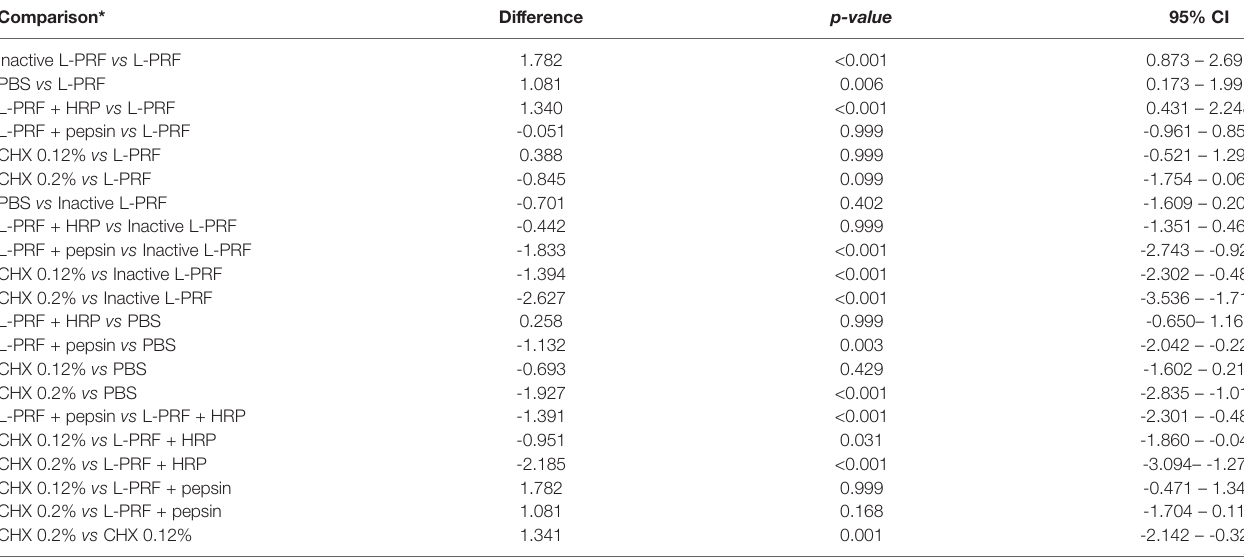
TABLE 4 | Comparisons of the effects of the tested solutions on P. gingivalis in developing multi-species bio fi lm experiments.